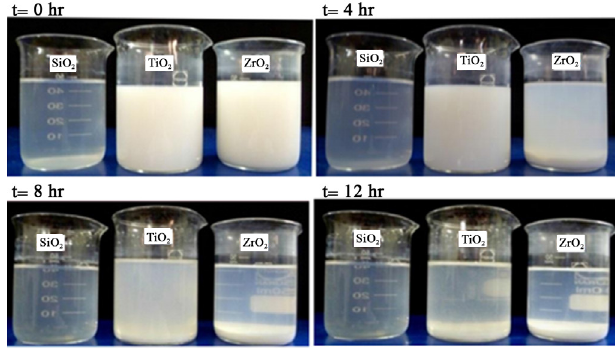
Fig. 2. Comparison of distribution stability for different nanoparticles in 0.1 vol%.